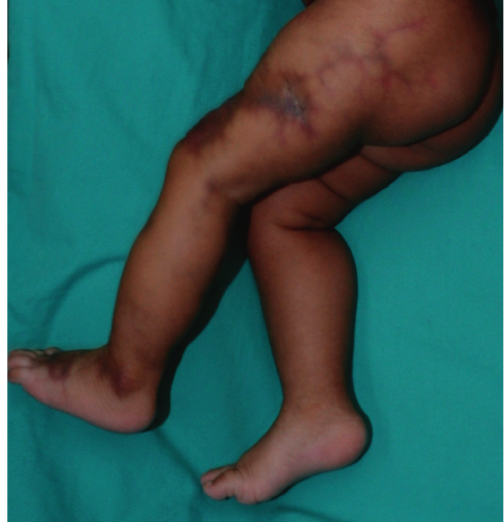
Figure 2: Cutis marmorata telangiectatica congenita on the left lower limb associated with ipsilateral hemiatrophy (lateral